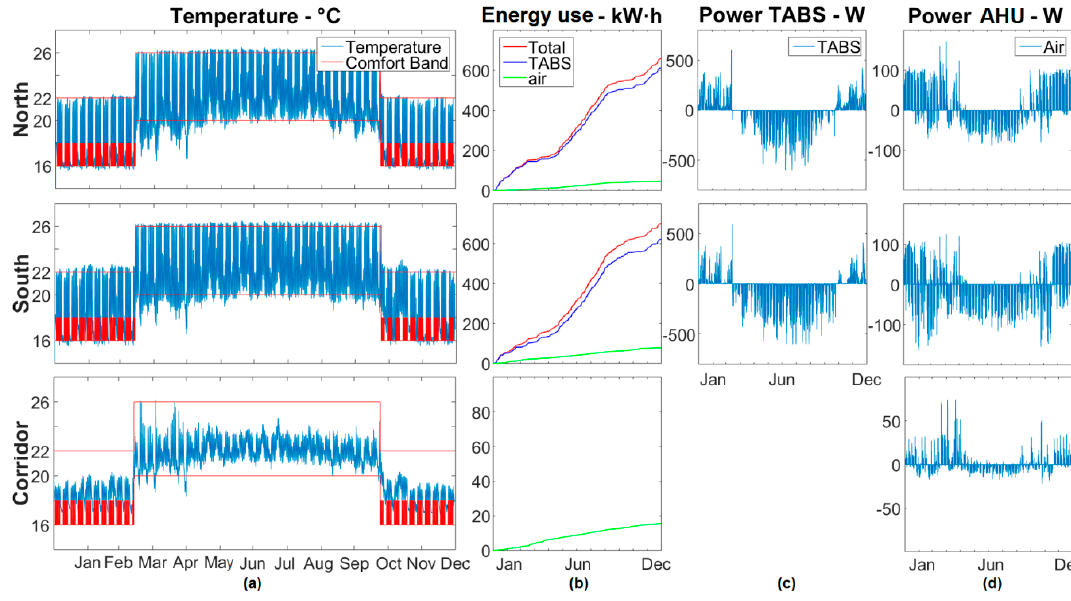
Figure 6. Enhanced BSC study: zone temperature evolution ( a ), accumulated energy use ( b ) and developed power in TABS ( c ) and in AHU ( d ).